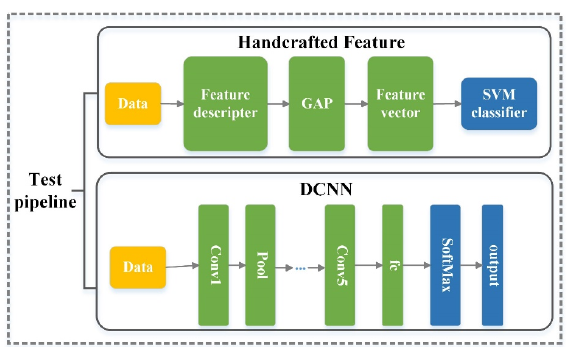
Figure 10. Test pipeline for RSI-CB (“Conv” means convolution layer, “Pool” means pooling layer, “fc” means fully connected layer, and “SoftMax” is an activation